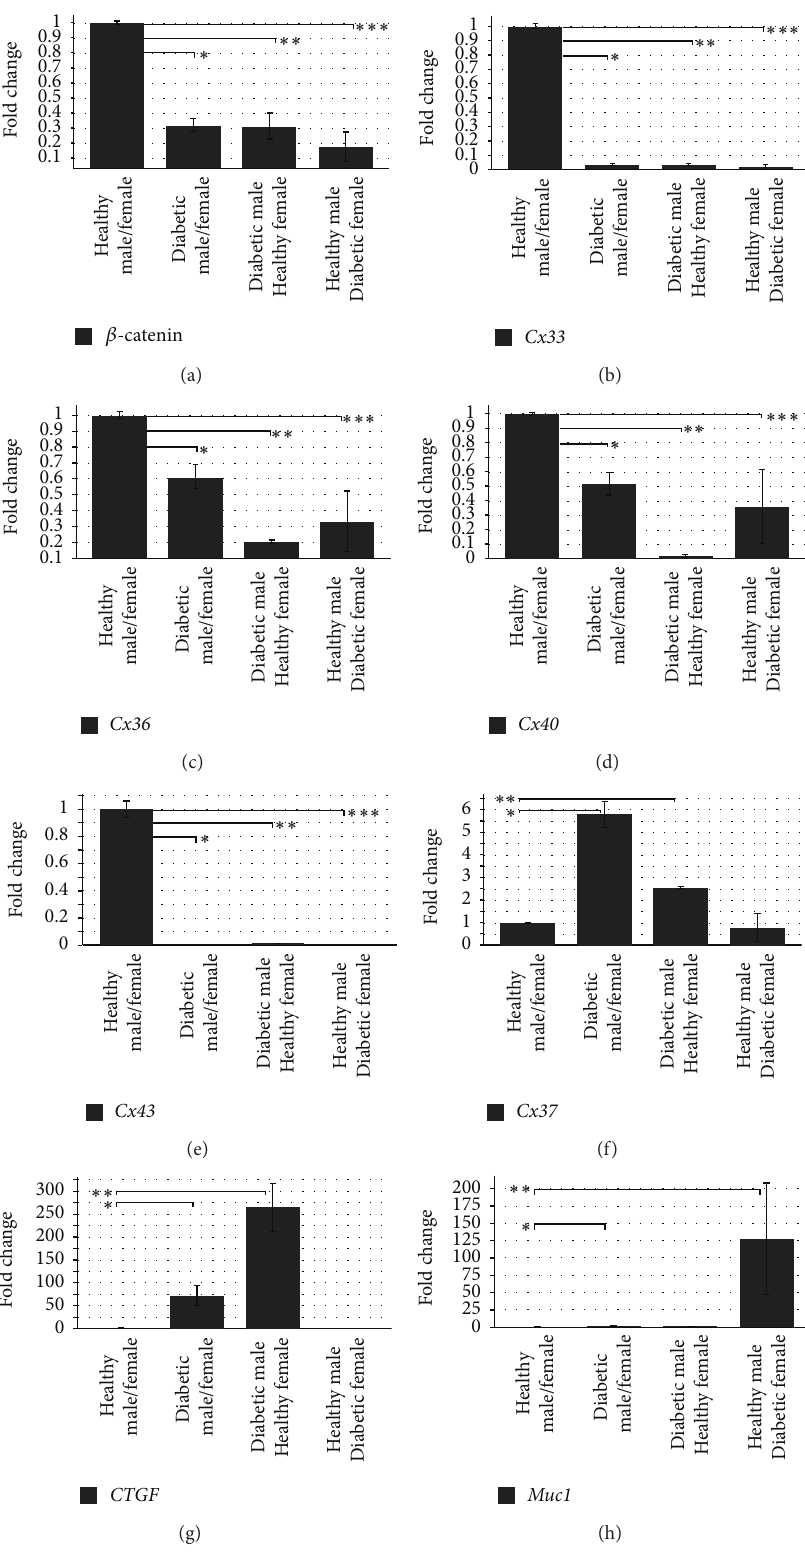
Figure 4: Significantly increased or decreased fold regulations of gene expression levels. (a) 𝛽 -catenin ( ∗ , ∗∗ , ∗∗∗ 𝑃 < 0.0001 ); (b) Connexin 33 ( ∗ , ∗∗ , ∗∗∗ 𝑃 < 0.0001 ); (c) Connexin 36 ( ∗ , ∗∗ 𝑃 < 0.0001 ; ∗∗∗ 𝑃 = 0.004 ); (d) Connexin 40 ( ∗ , ∗∗ 𝑃 < 0.0001 , ∗∗∗ 𝑃 = 0.01 ); (e) Connexin 43 ( ∗ , ∗∗ , ∗∗∗ 𝑃 < 0.0001 ); (f) Connexin 37 ( ∗ , ∗∗ 𝑃 < 0.0001 ); (g) CTGF ( ∗ , ∗∗ 𝑃 < 0.0001 ); (h) Muc1 ( ∗ 𝑃 = 0.026 , ∗∗ 𝑃 = 0.022